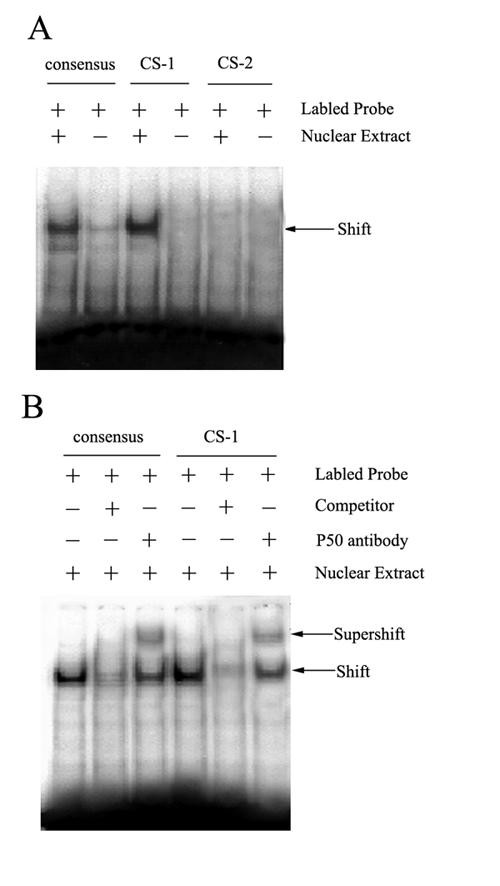
EMSA analysis of the NF-κB binding sites in the mouse CS-1 and CS-2 promoters. A. 32P labelled oligonucleotide probes for the NF-κB consensus, NF-κB CS-1 and NF-κB CS-2 binding sites were incubated with C2C12 myotube nuclear extracts. B. Competition experiments were performed using a 100-fold excess of unlabeled NF-κB consensus and NF-κB CS-1 probes. Supershift assays were performed with anti-P50 antibody. Arrows indicate the resulting bandshifts.